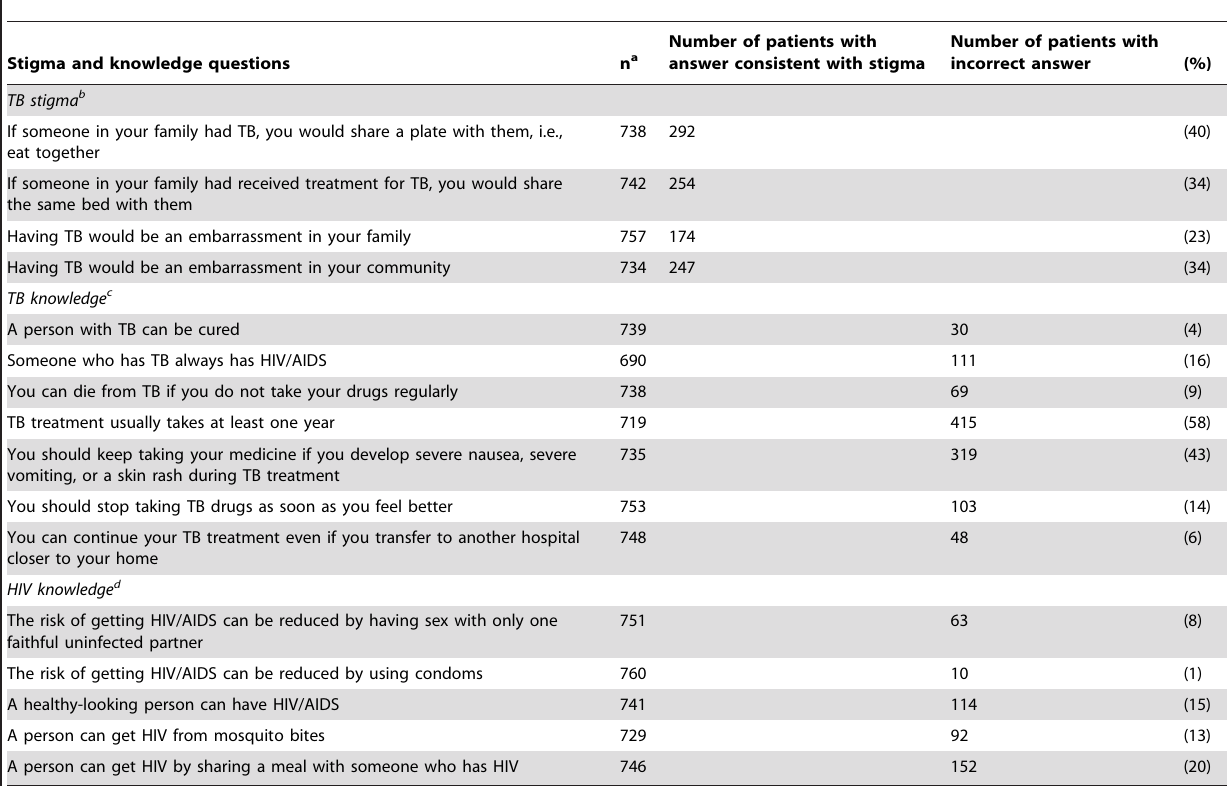
Table 1. Baseline TB stigma, TB knowledge, and HIV knowledge among HIV-infected TB patients in Thailand.